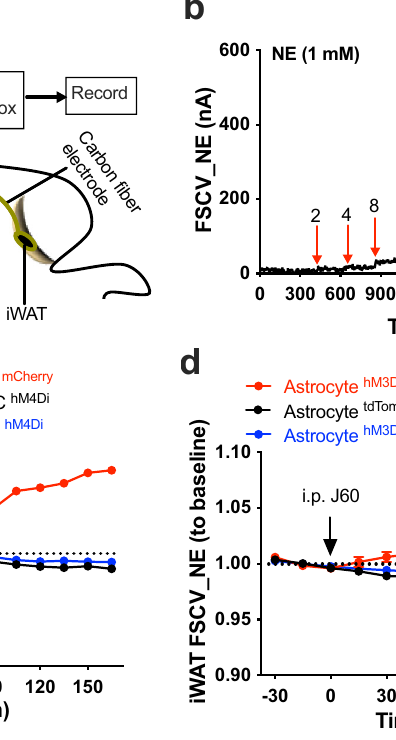
POMC neuron hM4Di ( n =5), or astrocyte hM3Dq POMC neuron hM4Di ( n =6)- transduced mice, respectively. Mice were treated with J60 via i.p. after a stable baseline. d Averaged traces from c (Astrocyte hM3Dq POMC hM4Di , n =6; Astrocyte hM3Dq POMC mCherry , n =5; Astrocyte tdTomato POMC hM4Di , n =5). Two-way ANOVA with Sidak post hoc tests; data represent mean±s.e.m.; ** p =0.006<0.01; *** p =0.0002<0.001; **** p <0.0001. Red arrows in b indicate the time points of adding NE in different volumes. Black arrows in d point to i.p. injections of